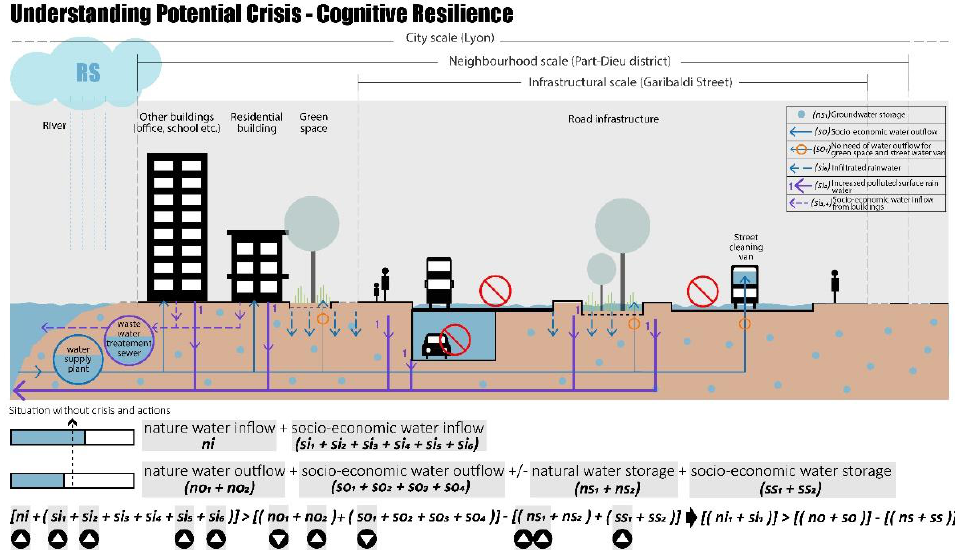
Figure 5. Rainy scenario, cognitive resilience in Part-Dieu District, realised by authors.